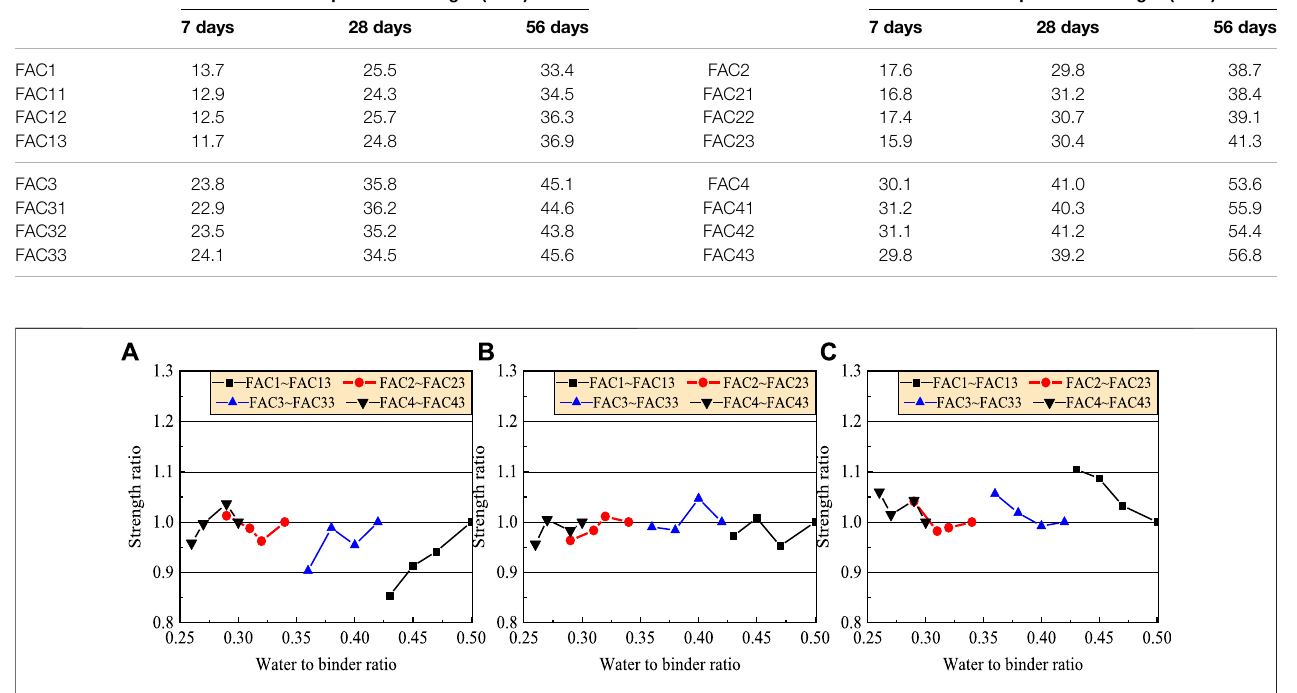
FIGURE 4 | Changes of the strength ratio with the water-to-binder ratio at the curing age of (A) 7 days; (B) 28 days; and (C) 56 days.